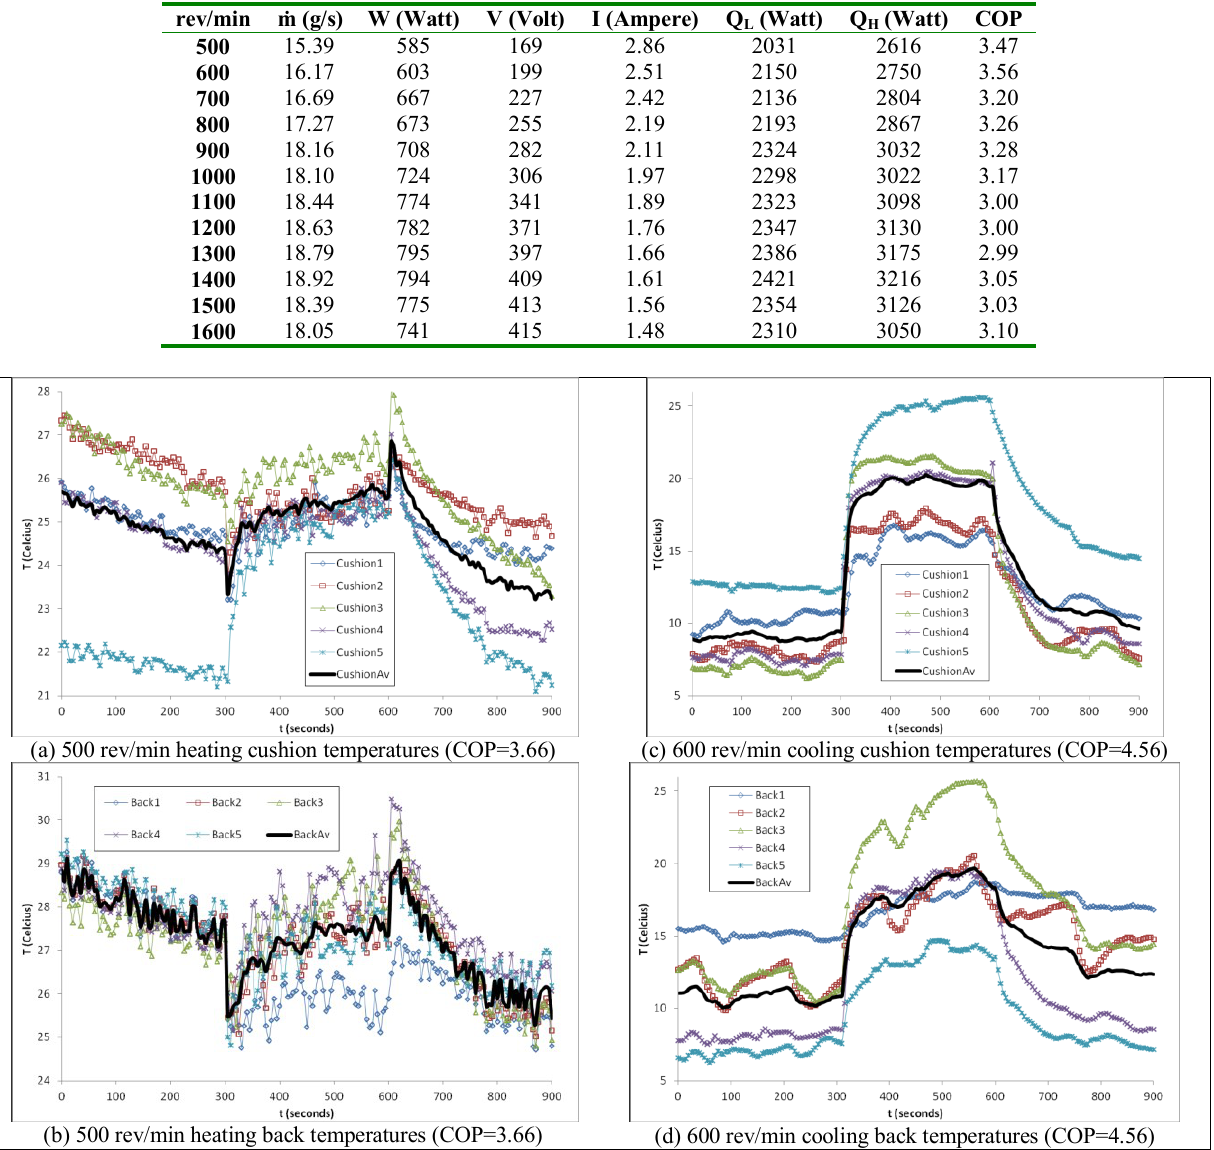
Fig. 6. Point temperature measurements of the seat for heating and cooling at the highest COP